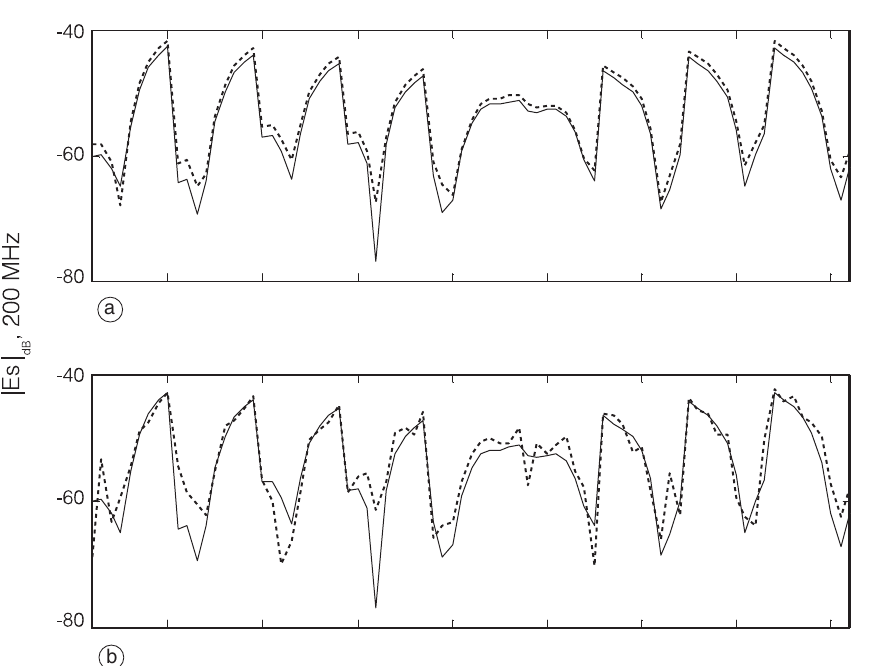
Fig. 7a,b. Case 2: a conductivity anomaly. a) Comparison between actual scattered data (solid line) and data that would result according to the BA model (dotted line). b) Comparison between clean data (solid line) and data corrupted by noise with an SNR = 10 dB (dotted line).The plotted quantity is the modulus of the field at 200 MHz for each location of the transmitter and the receiver.